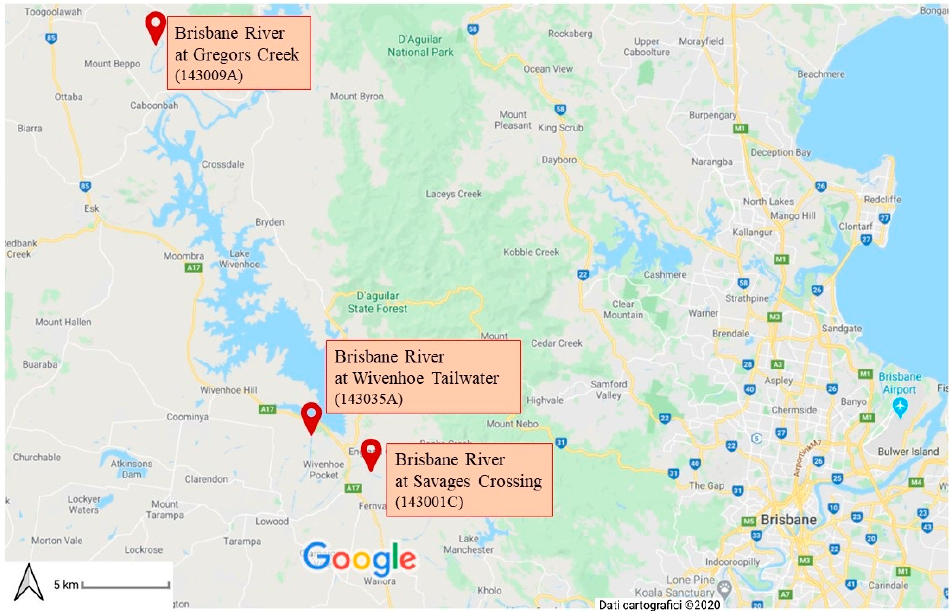
Figure 8. Location of the case study and gauging stations selected for the model application (Source: Google Maps).